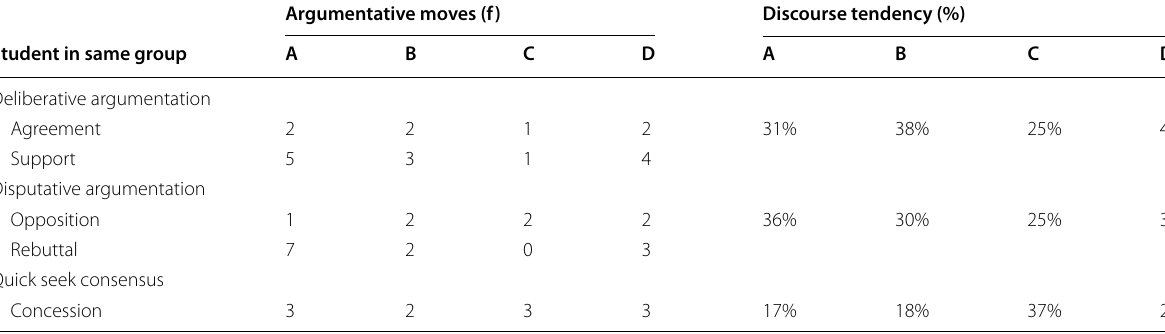
Table 1 Argumentation tendency of four in a group Argumentative moves